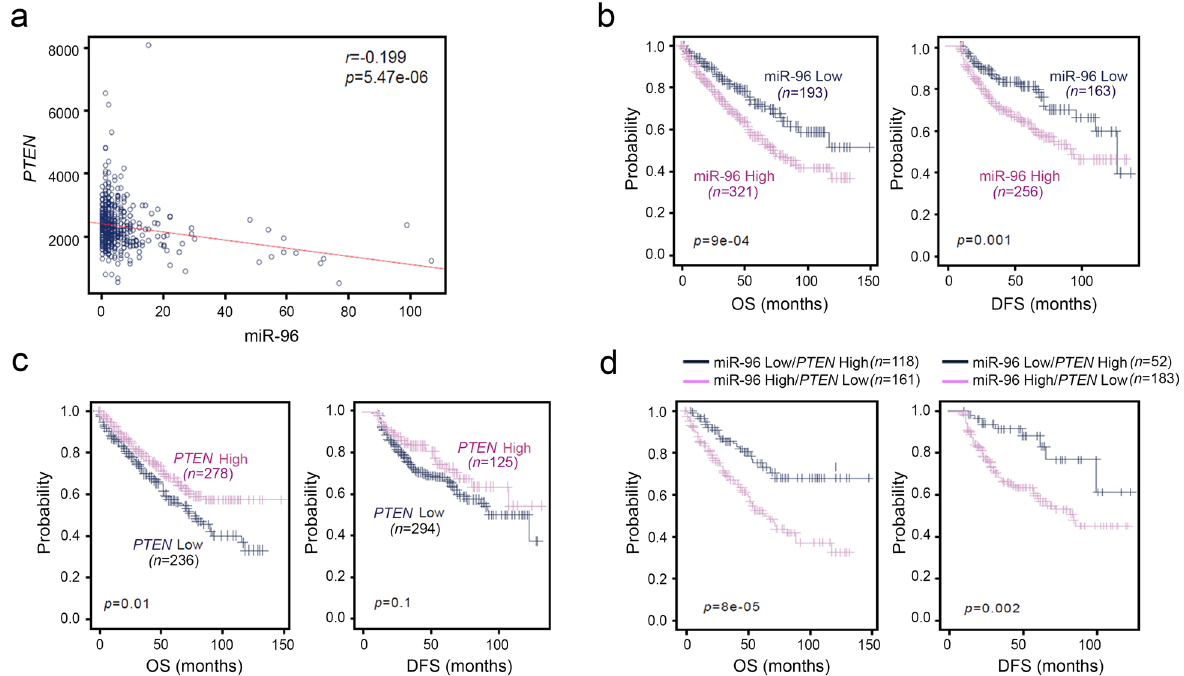
Figure 3. Associations of higher miR-96 and lower PTEN expression levels with a poor prognosis in CCRCC patients. ( a ) The correlation between miR-96 and PTEN expression in TCGA CCRCC patients (KIRC) was estimated using Pearson’s correlation test. ( b–d ) Kaplan–Meier curves of overall survival (OS) and progression- free survival (PFS) for miR-96 and PTEN expression in CCRCC patients. miR-96 and PTEN expression was dichotomized into high- and low-expression categories (b, c). CCRCC patients in KIRC were dichotomized based on the expression of miR-96 and PTEN and patients with higher expression levels of both miR-96 and PTEN or lower expression levels of both miR-96 and PTEN were identified for analysis ( d